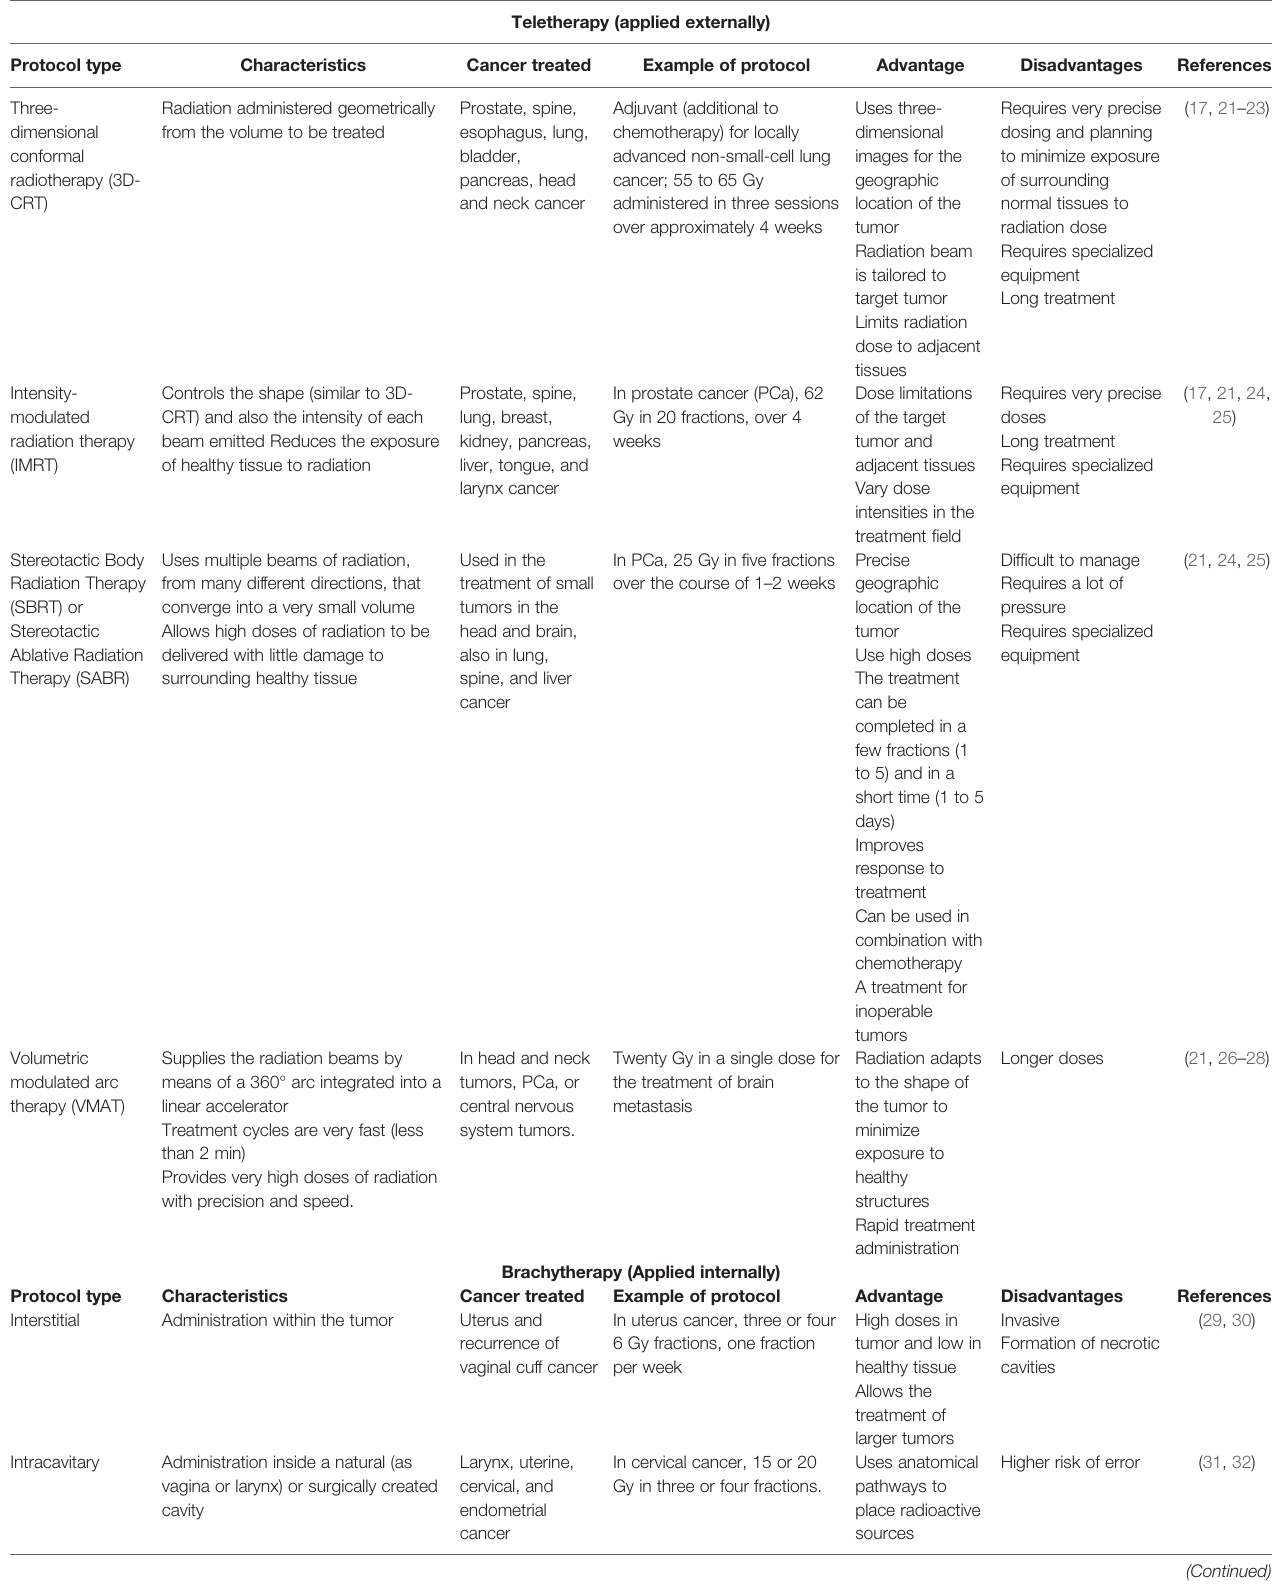
TABLE 1 | Types of radiotherapy used in clinical practice for the treatment of different types of